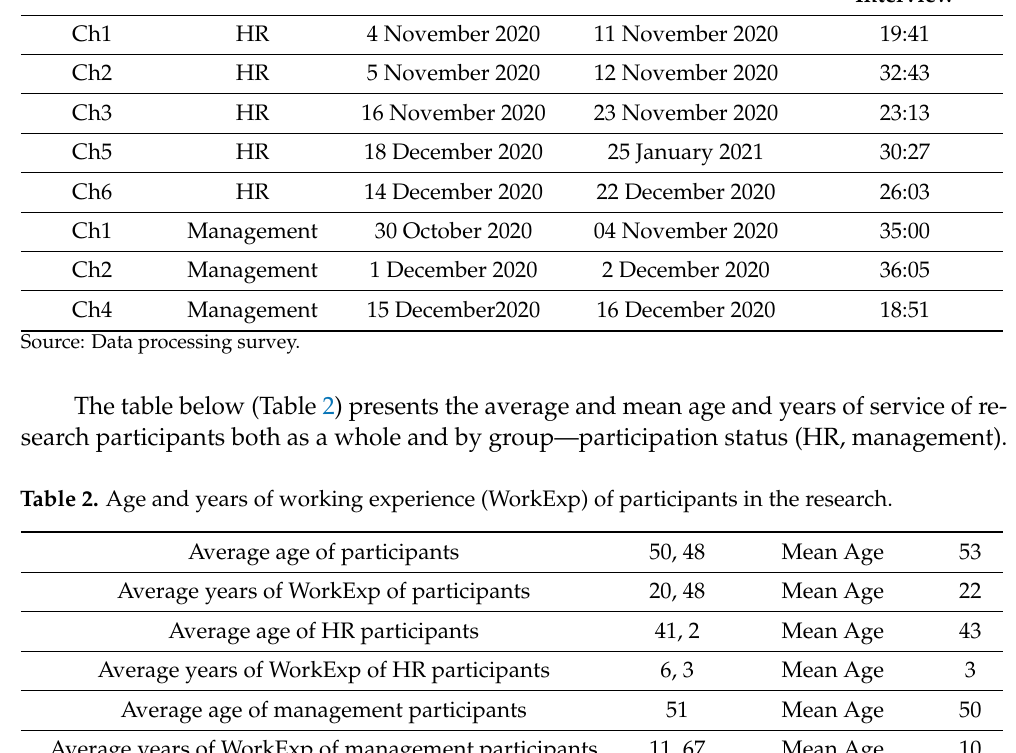
Table 1. Interview scheduling and Duration. Company Role